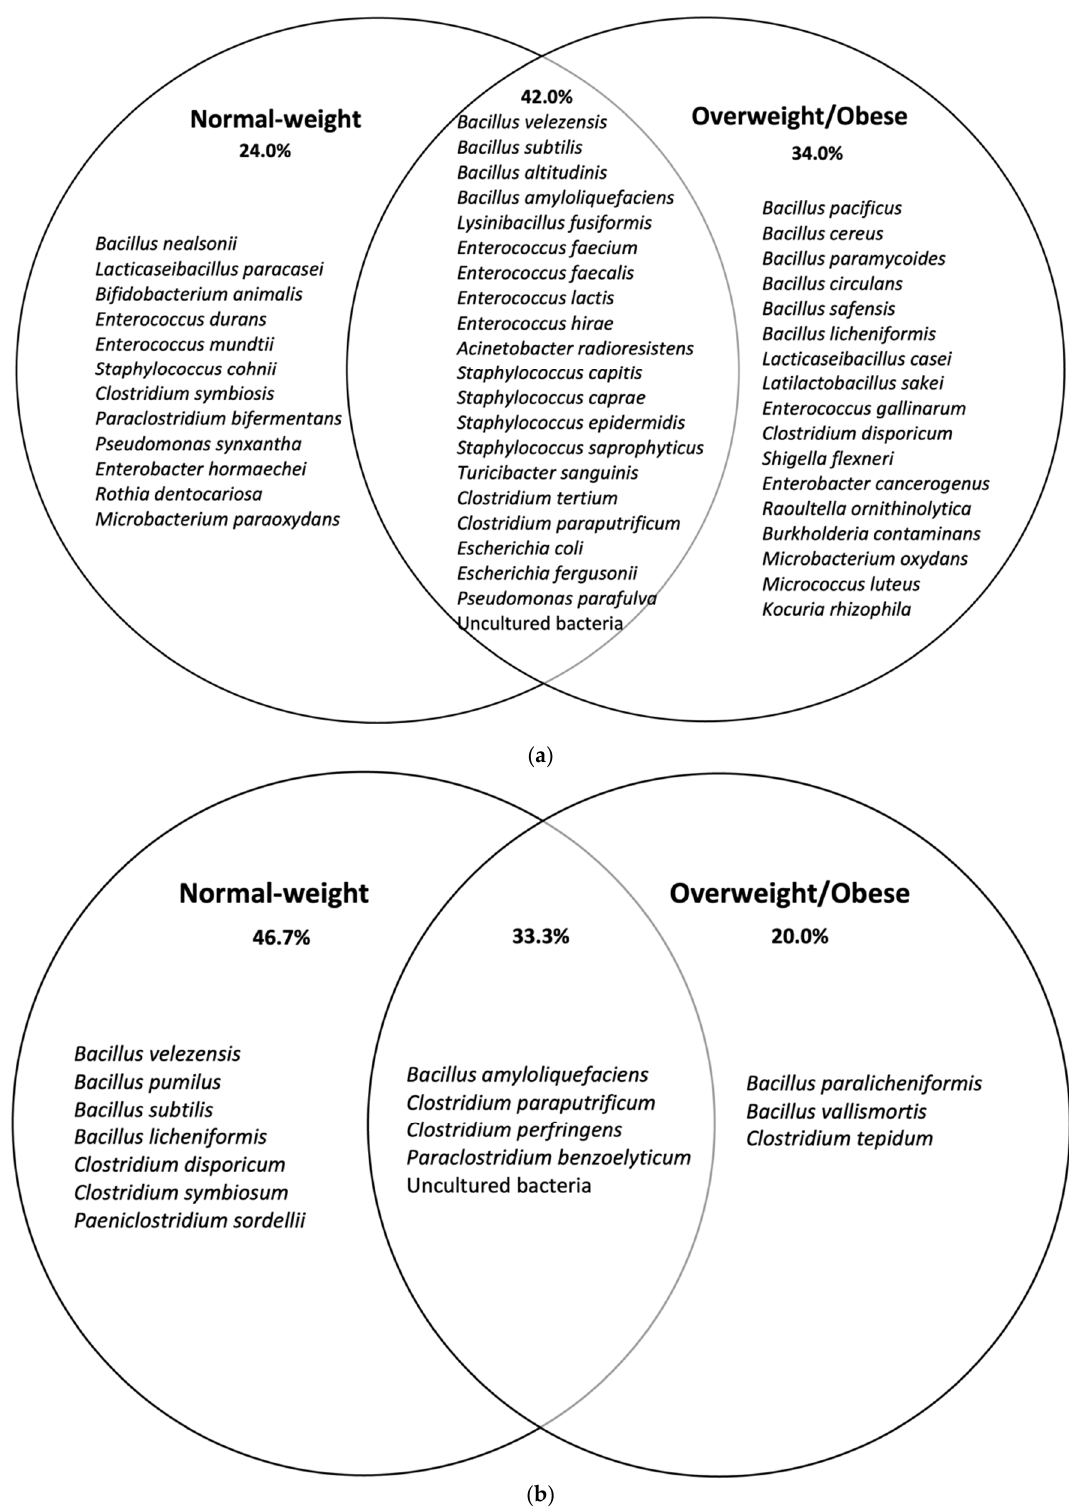
Figure 1. Venn diagram analyses of species isolated in normal-weight and overweight/obese children after in ( a ) BPA directed culturomics and ( b ) BPA directed culturomics spore-forming bacteria (sporobiota).